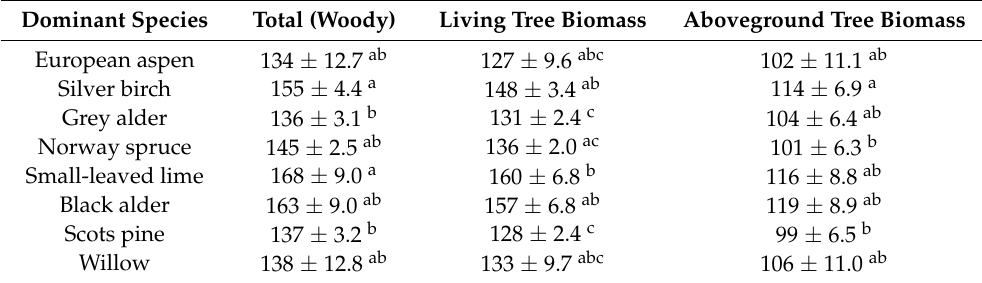
Table 5. The estimated marginal means ( ± standard error) of total woody, living and aboveground biomass carbon pools according to dominant tree species of the studied small and medium rivers of riparian forest stands in Latvia. The similar letters (as indices) indicate the lack of pairwise significant differences according to the Tukey’s post hoc